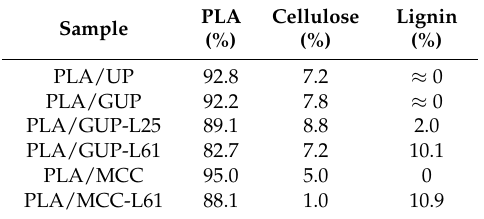
Table 3. Composition of the PLA/cellulose biocomposite spheres (see Table 1 for sample identification).